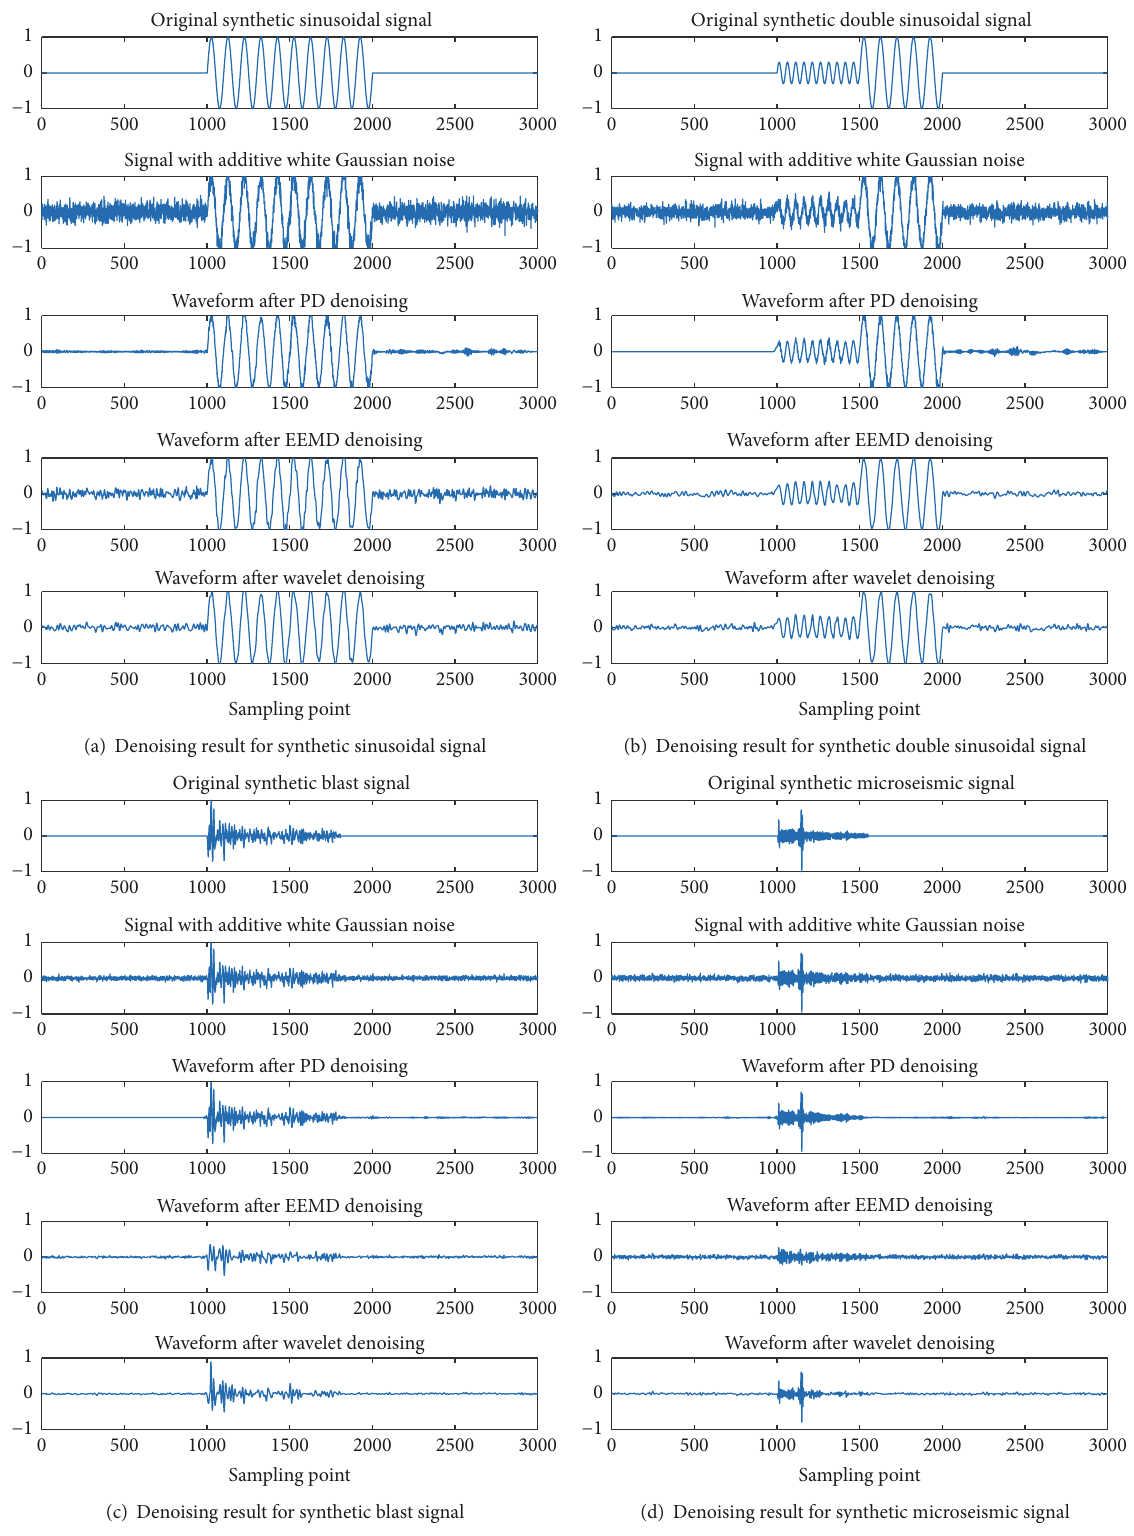
Figure 2: Comparison of signal denoising result with different